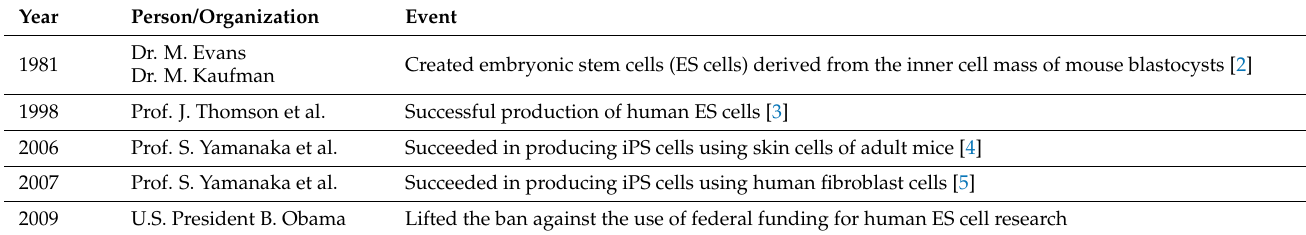
Table 1. Overview of ES and iPS cells.